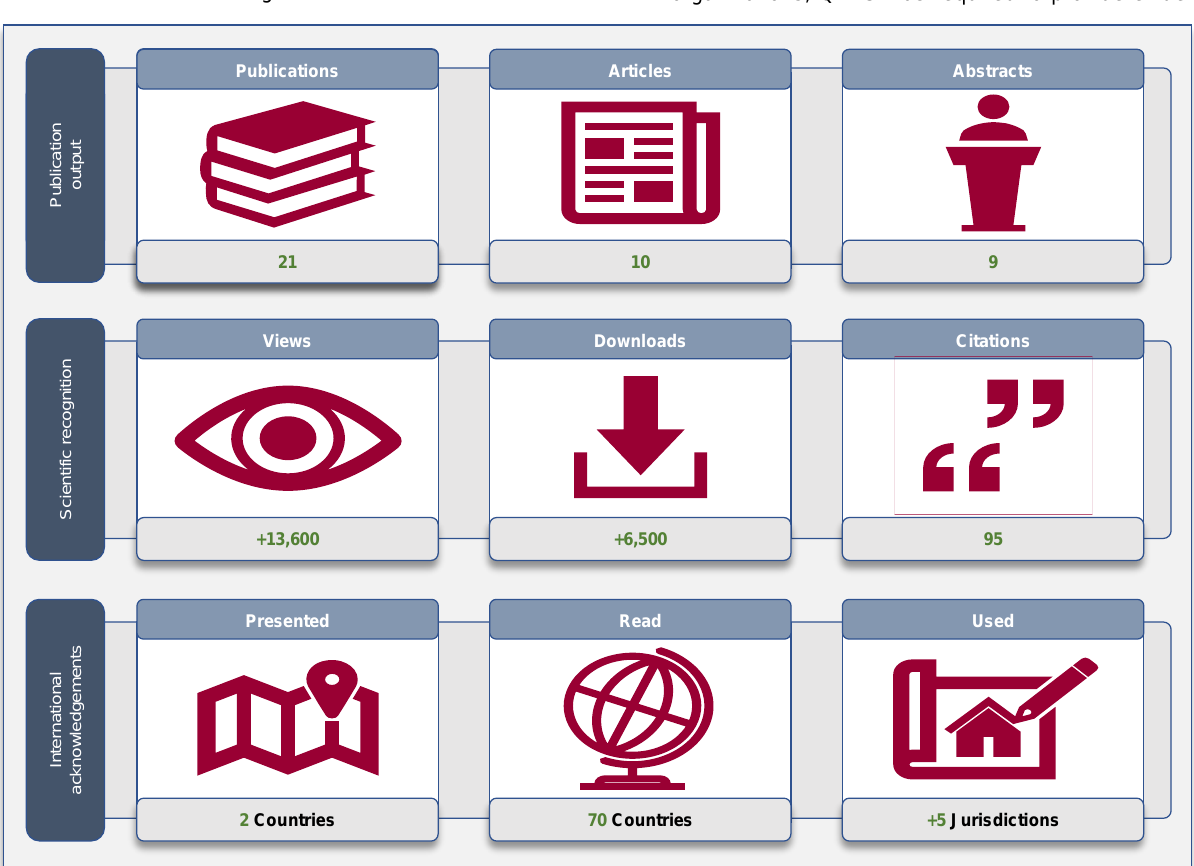
Figure 2: Key indicators of the overall scientific impact of the research project (e.g., publication output, scientific recognition, international acknowledgments) focusing on the health service delivery and health economic evaluation of limb lower bone-anchored prostheses lead by the Queensland Artificial Limb Service between 2015 and